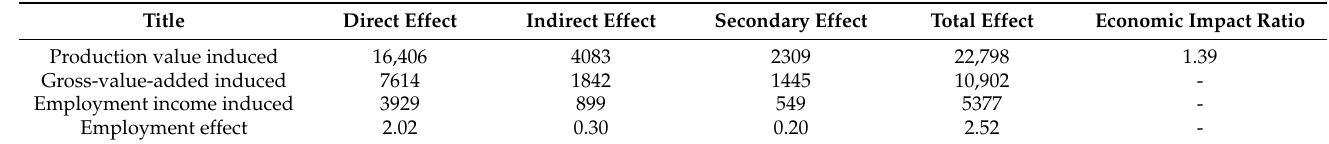
Table 8. The economic impact (measured in thousands of yen or in people) of issuing a premium